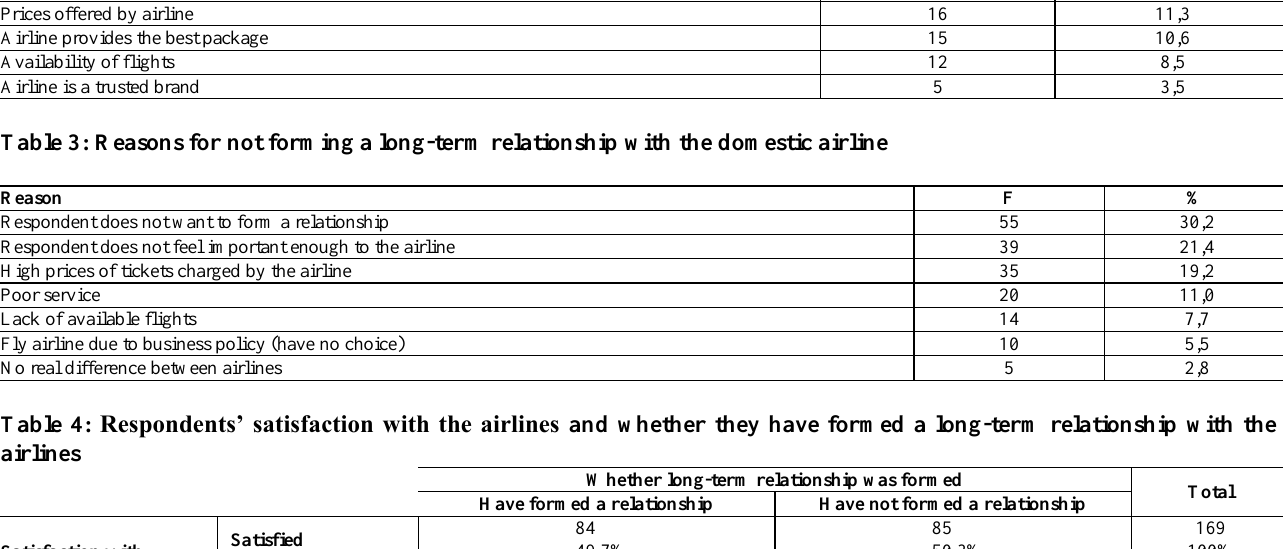
Table 2: Reasons for forming a long-term relationship with the domestic airline Reason